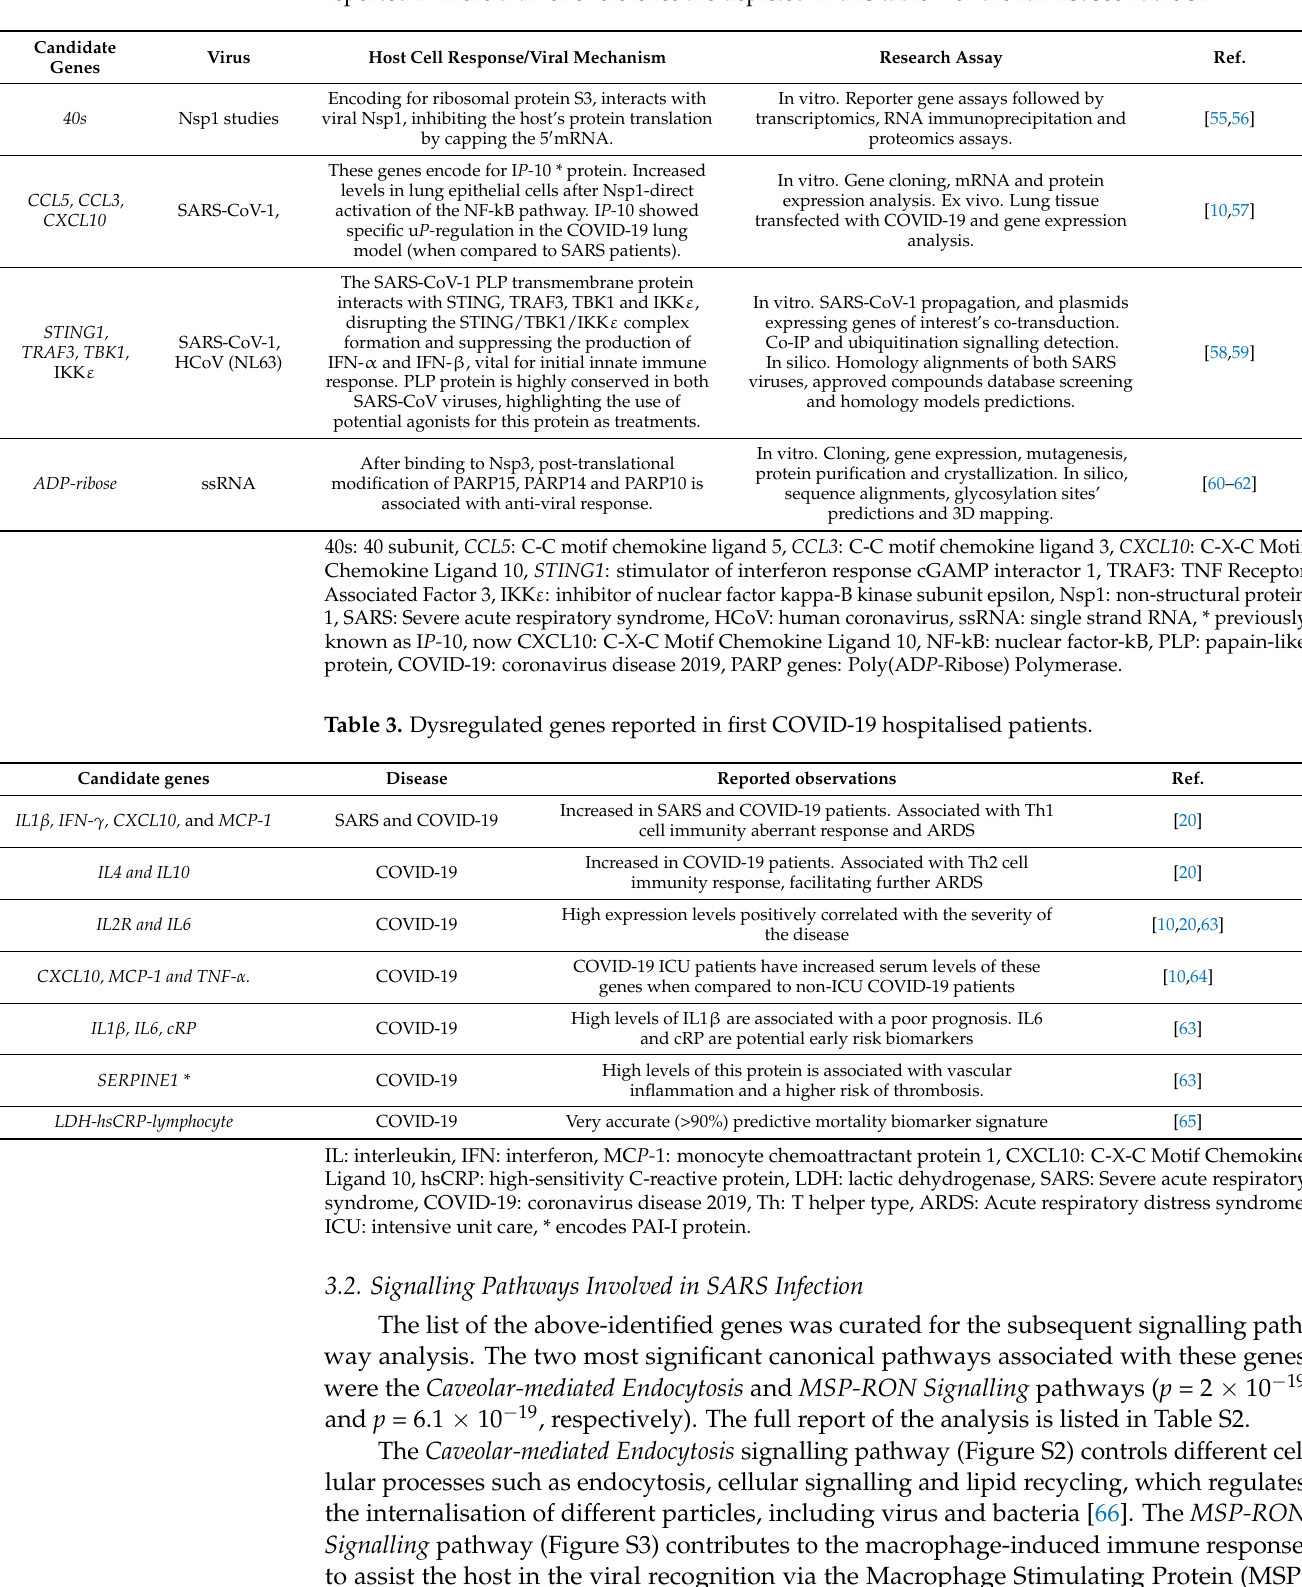
Table 2. Host cell candidate genes associated with viral immune system evasion. Only those genes reported in more than one reference are depicted in this table. For the full list see Table S1.